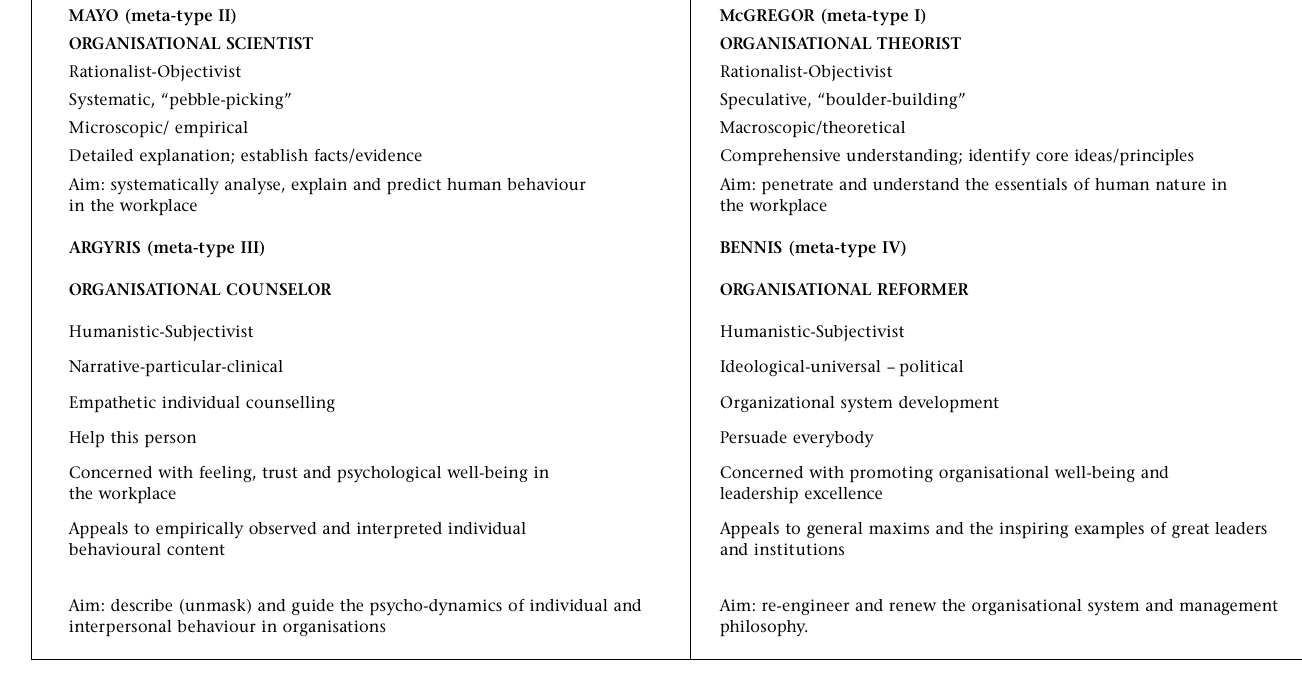
Figure 2: Meta-paradigm exemplars in I/O psychology (adapted from Pietersen,